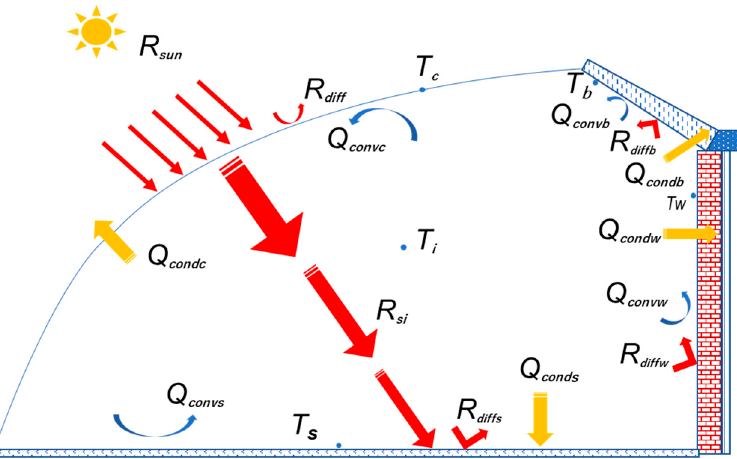
Figure 6. Illustration of the overall heat balance in the CSG.